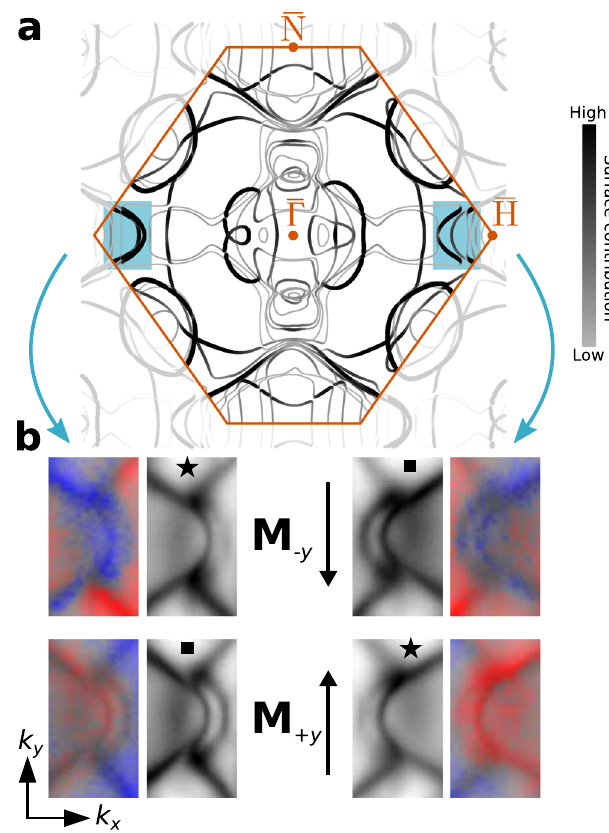
Fig. 3 | Fermi-arc switching induced by magnetization reversal. a Theoretical Fermi surface of 2 MLs Fe/W(110) for the in-plane magnetization M − y . Colours represent the degree of the states' localization in the magnetic layers, and the shaded regions highlight the emergent Fermi arcs. b Measured spin-resolved and spin-integrated surface arc states in the highlighted regions of a for the two mag- netization directions M + y and M − y that are parallel and anti-parallel to the y direc- tion, respectively. The shape and the spin polarization of the strongly asymmetric Fermi arcs on opposite sides of the momentum map is interchanged if the mag- netization direction is reversed asvisualized by the black starand square symbols. The spin polarization P y is indicated by red and blue colours, and the colour strength encodes the